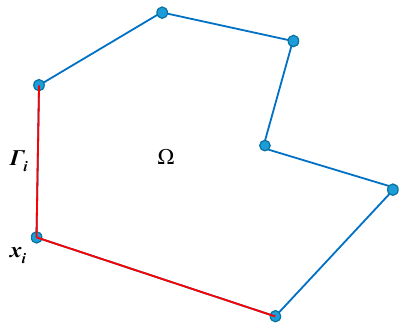
Figure 2. A polygon and its boundary division.